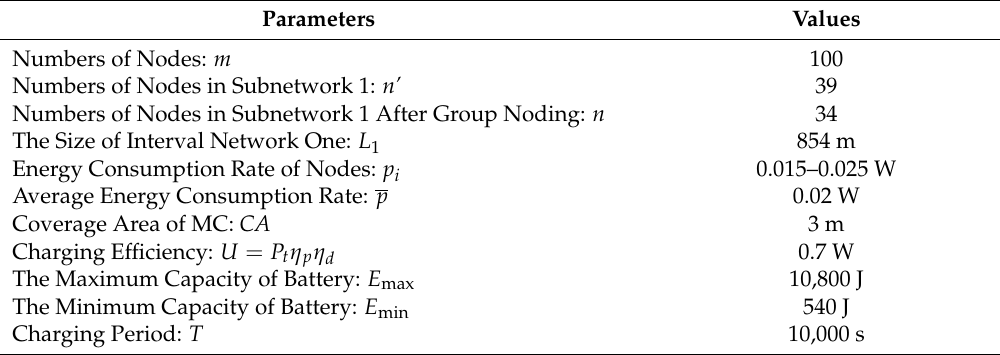
Table 1. Simulation parameters of the charging configuration.